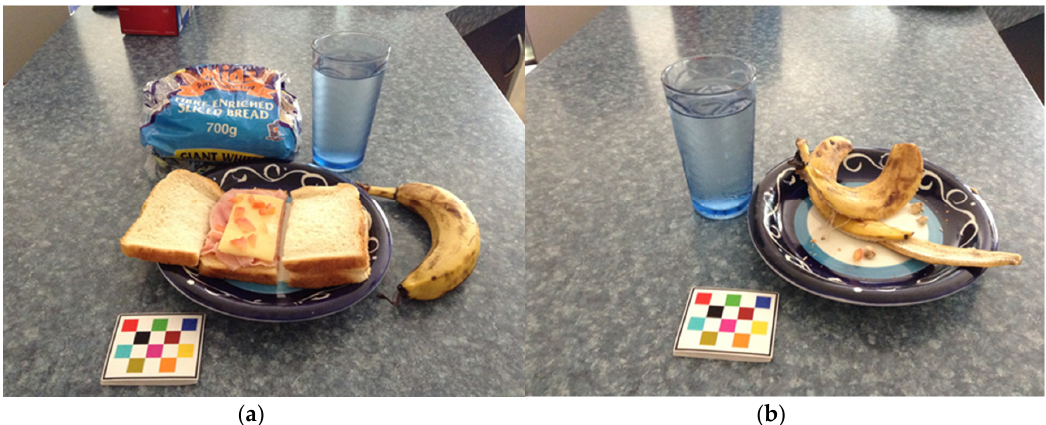
Figure 2. Example of the image capture by a PANDs participant using the mFR. ( a ) Before eating image; ( b ) After eating image. The image also shows the inclusion of the fiducial marker in the images. The loaf of bread was included in the image to help with identification of the type of bread consumed, only what was on the plate was analysed.